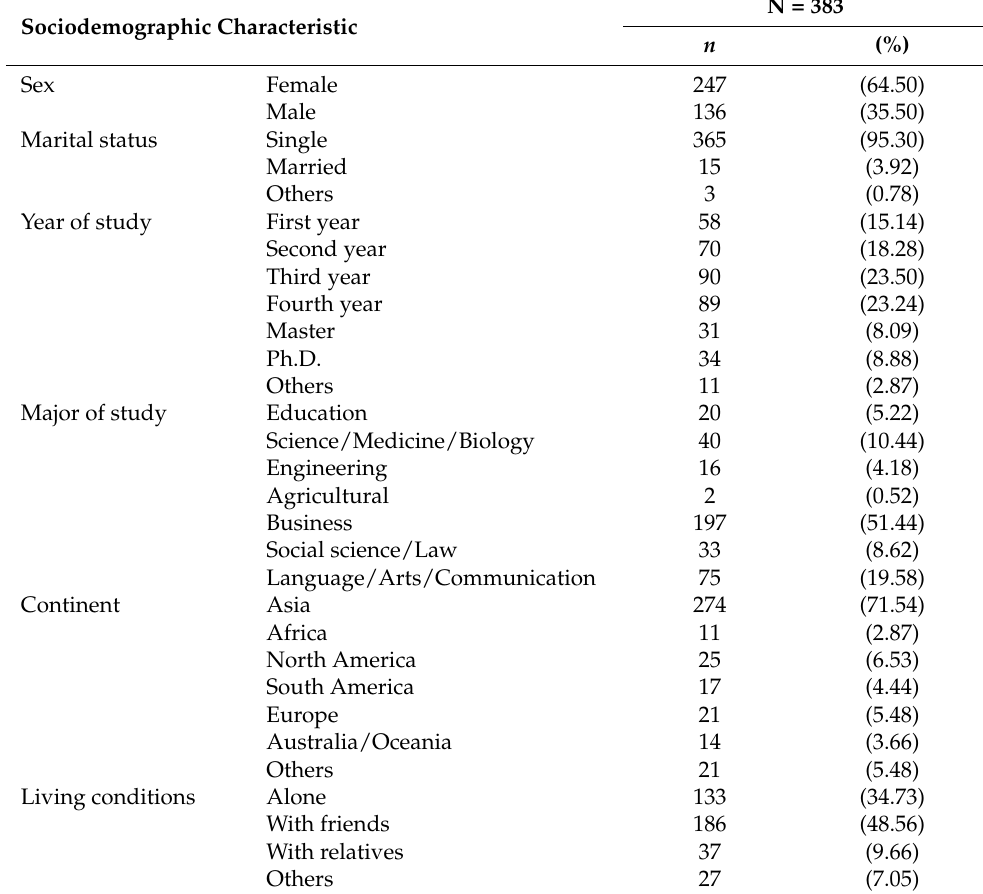
Table 1. Sociodemographic characteristics of respondents (N =